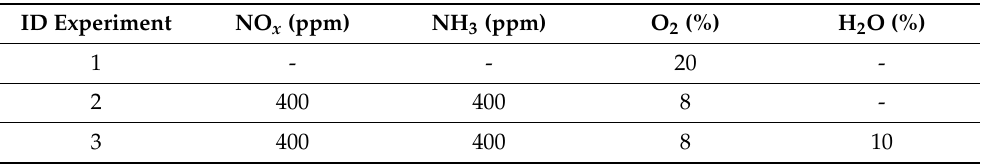
Table 2. Composition of the inlet reaction mixtures during transient and steady-state experiments according to the protocol described in Figure 1.